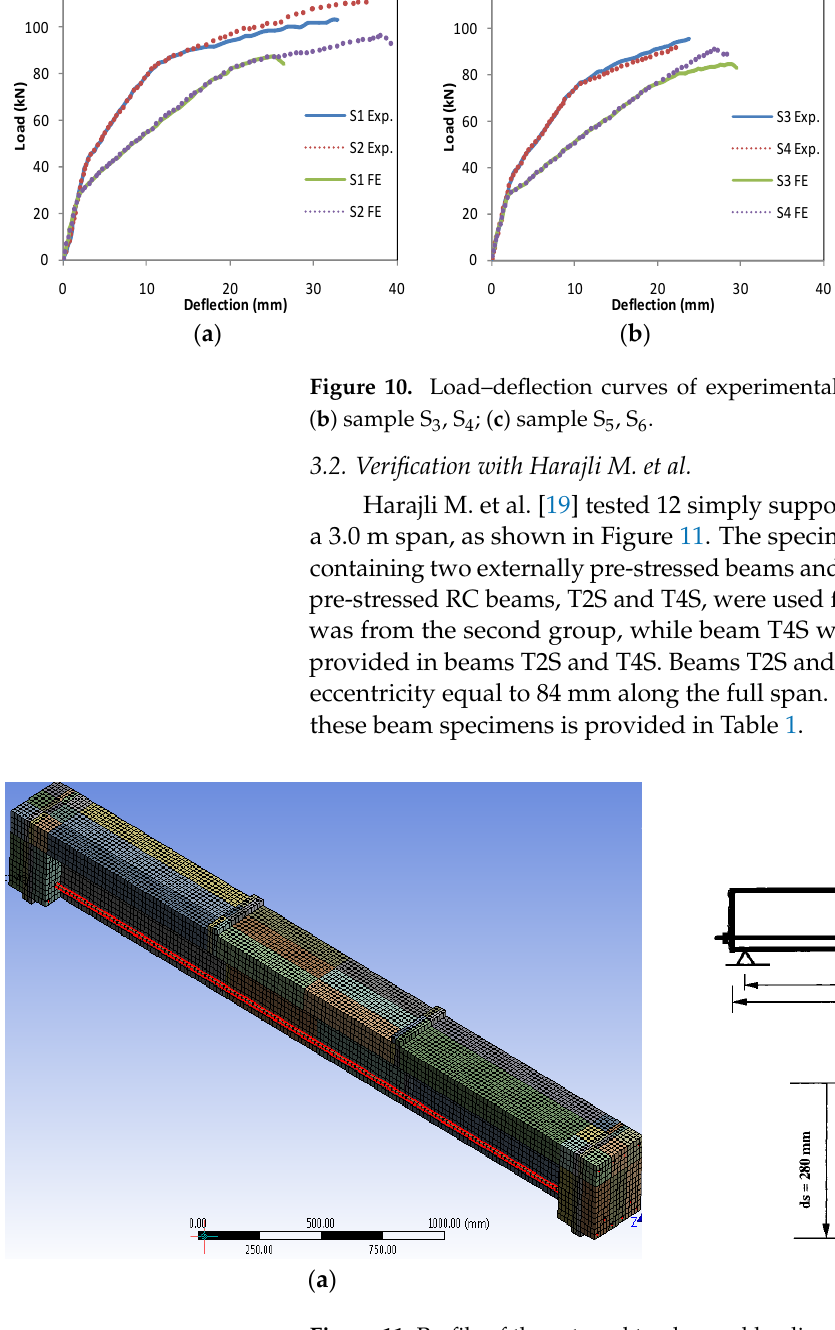
Figure 11. Profile of the external tendon and loading: ( a ) finite element; ( b ) laboratory.